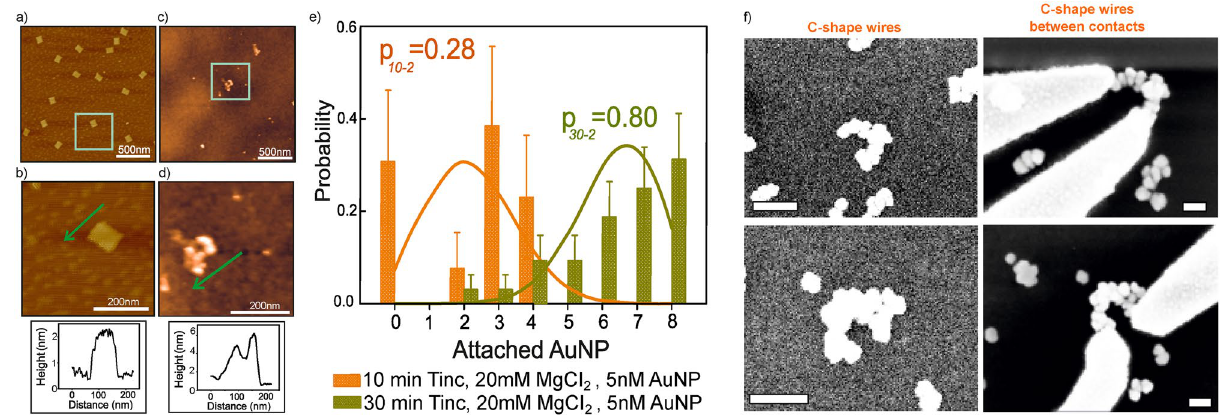
Figure 2. ( a ) AFM height images of immobilized bare DNA origami sheets and ( b ) a high magnification AFM image of an individual nanosheet (green box in a )) on a SiO 2 surface. ( c ) AuNPs attached to DNA origami at specific positions with high attachment yield and ( d ) high magnification AFM image of an individual AuNP decorated nanosheet (green box in c )). Inset figures show a cross-sectional profile of the individual origami and AuNPs decorated origami in b) and d), respectively. Green arrows indicate scan direction. ( e ) Measured attachment probabilities of AuNPs obtained from collected AFM images (histograms) and expected binomial distributions (solid lines) for two experimental conditions. The average attachment probabilities of AuNPs site occupation, p, are given for each case. ( f ) SEM images of two typical C-shape nanowires before and after being contacted by Au electrodes. Scale bars in in SEM images are 250 nm and 100 nm before and after gold contacts,